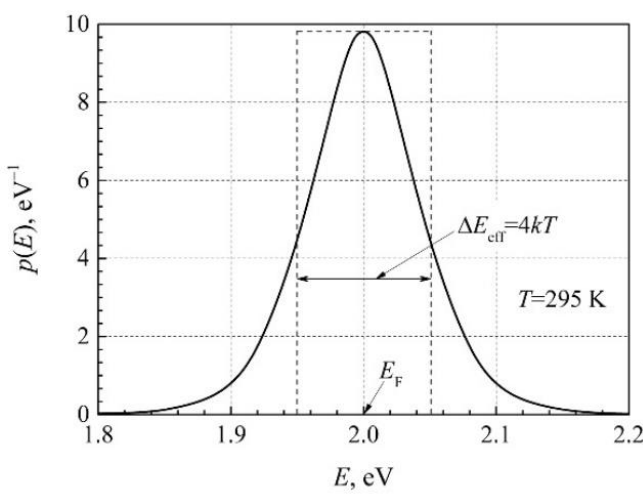
Figure 1. Illustration of the probability density function p ( E ) dependence on the energy of the RM electrons near the Fermi level energy E F = 2 eV at T = 295 K.